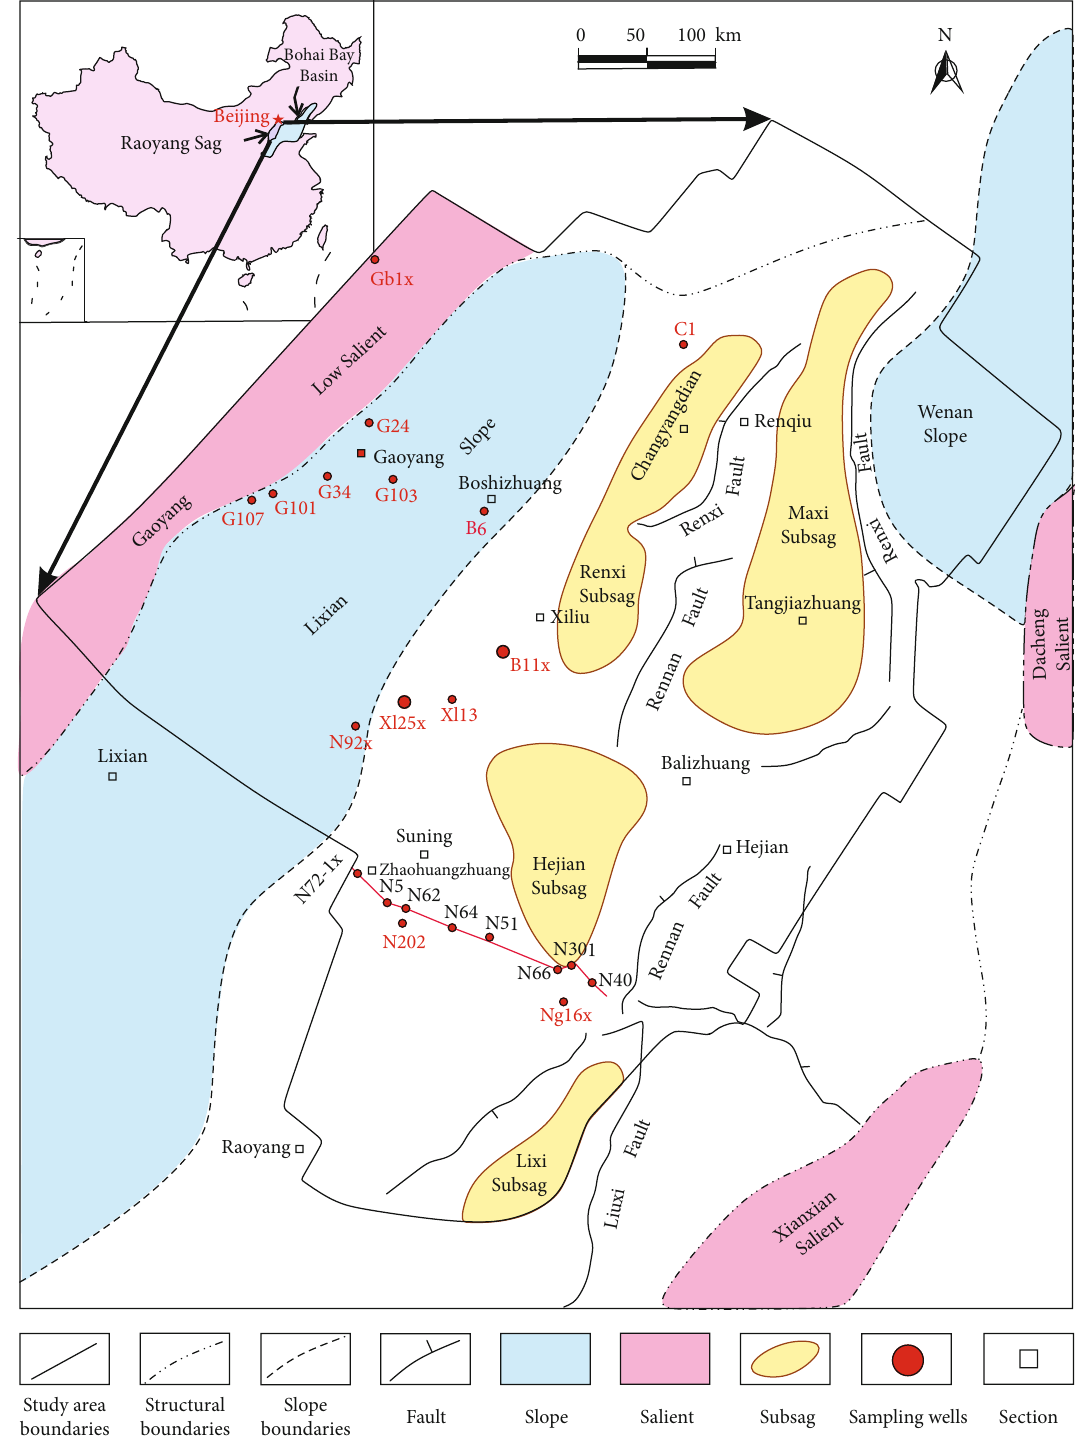
Figure 1: Structural map and well locations of the Raoyang Sag (modi fi ed after